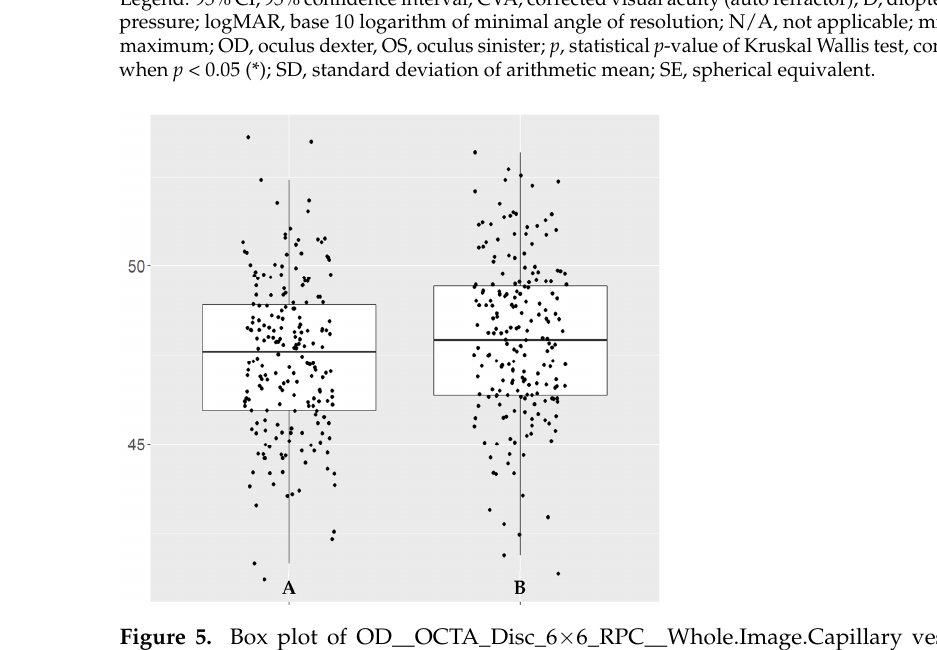
Figure 5. Box plot of OD__OCTA_Disc_6 × 6_RPC__Whole.Image.Capillary vessel density (%). ( A ) Control group. ( B ) COVID-19 group. Detailed demographic data are provided in Table 1. Green and red laser UWF ophthalmoscopy (SLO) and auto fl uorescence (AF) images from both eyes of 466 study participants were available. Of the 932 eyes, 616 (66.09%) were classi fi ed as “unremarkable” based on available imaging data. A total of 26 eyes (5.58%) showed peripheral degenerative alterations, 34 (7.3%) showed “other retinal fi ndings”, 85 (18.24%) showed retinal vessel tortuosity, 18 (3.86%) showed optic nerve head anomalies, and 10 (2.15%) showed “other optic nerve head fi ndings”. No co tt on wool spots, hemor- rhages, or Hollenhorst plaques were observed in any of the 932 eyes.